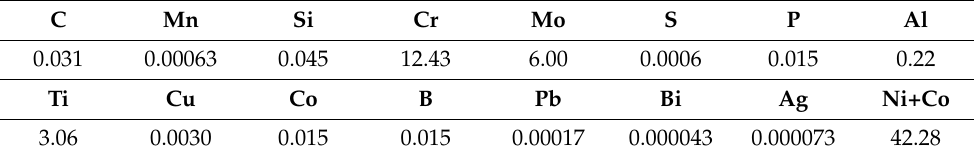
Table 1. Chemical composition of GH901 superalloy (wt.